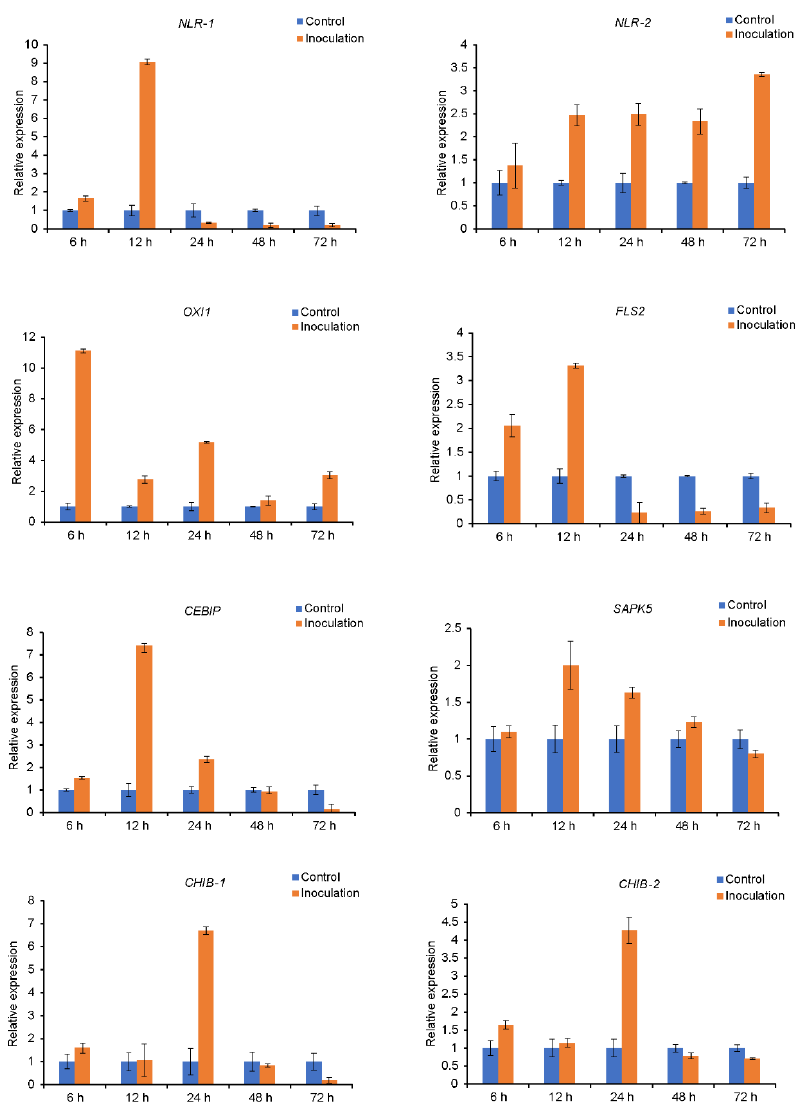
Figure 7. Expression patterns of disease resistance-related genes of the addition line II-9-3 at five time points after inoculation.